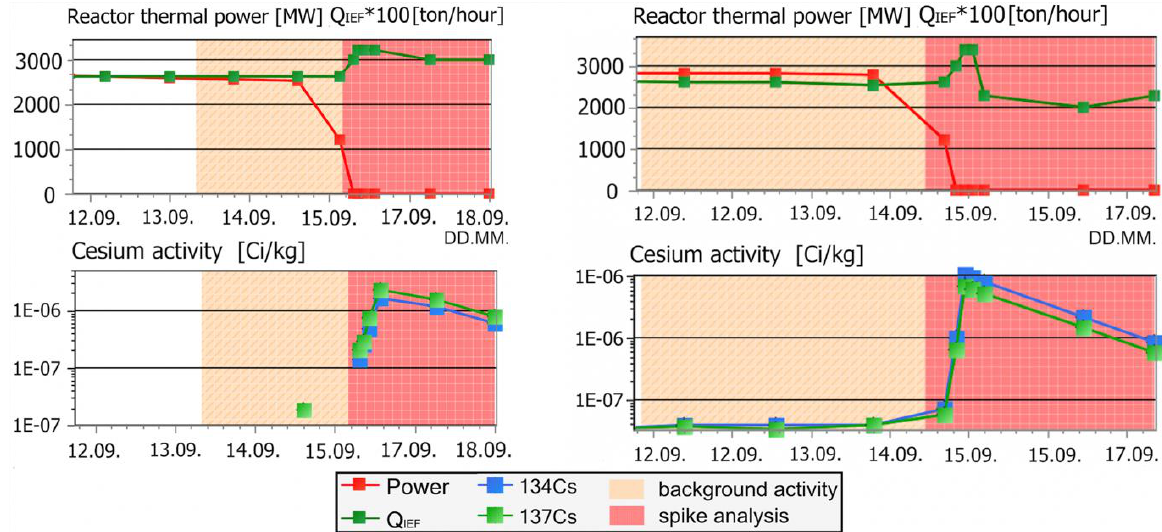
Figure 3. NPP data for caesium activity spike-event after the reactor shutdown: case #1 (left) and #2